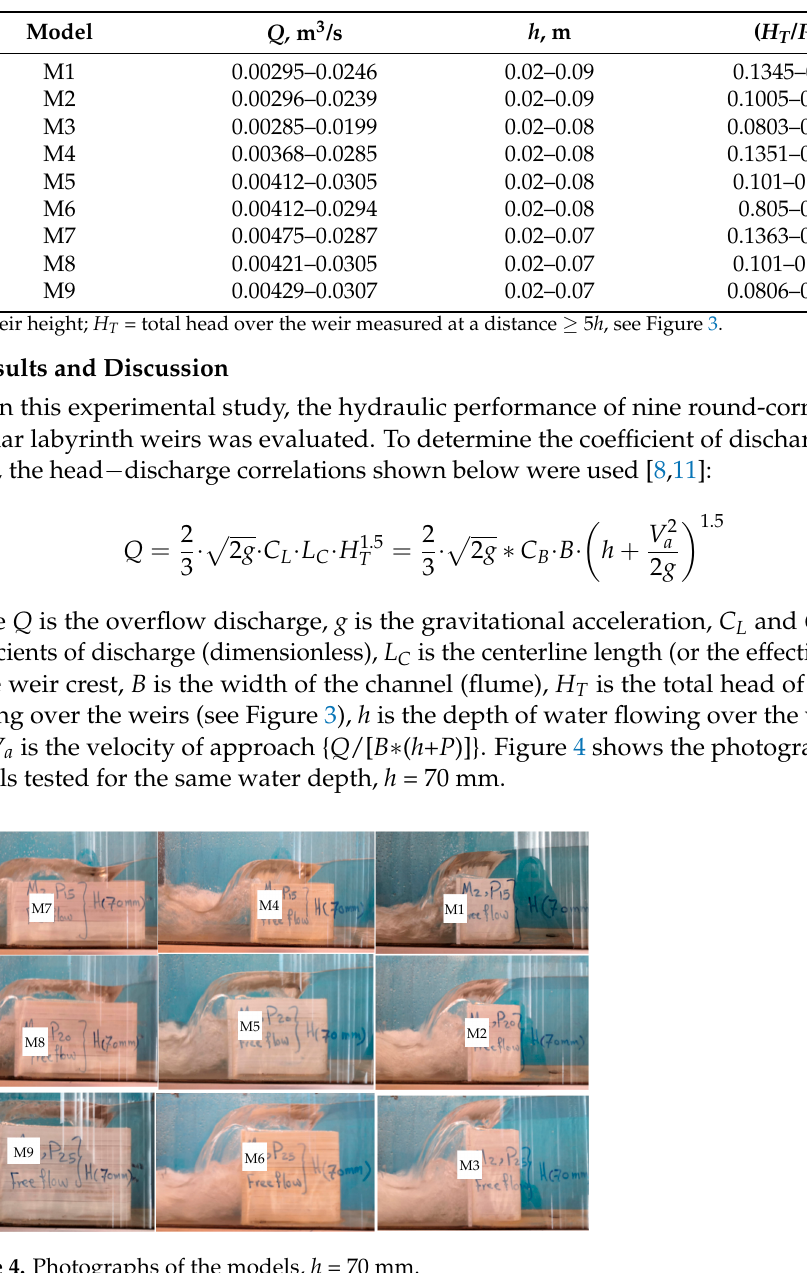
Table 2. Details of the experimental runs.